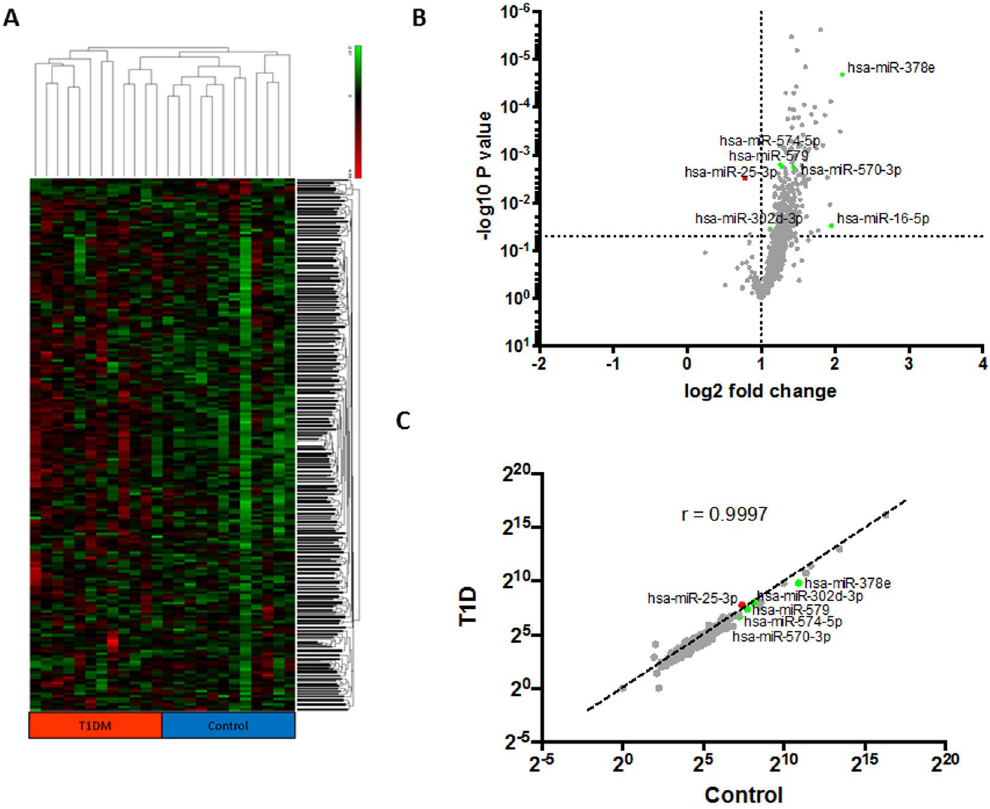
Figure 2. Differential miRNA content in T1DM and control subjects. Heatmap of the per-row normalized expression levels of selected miRNAs differentially expressed in T1DM and control subjects plasma-derived exosomes ( A ). Scatter plot of proteins enriched in Control or T1D subjects, n = 12 per group, using P < 0.05 (multiple t-test) and array threshold as cutoffs. Noted in the legend are Control subjects overexpressed miRNAs (green), T1D overexpressed miRNAs (red) ( B ). Correlation plot of exosome miRNAs, indicating in red and green those miRNAs expressed differentially T1DM and control subject’s exosomes ( C